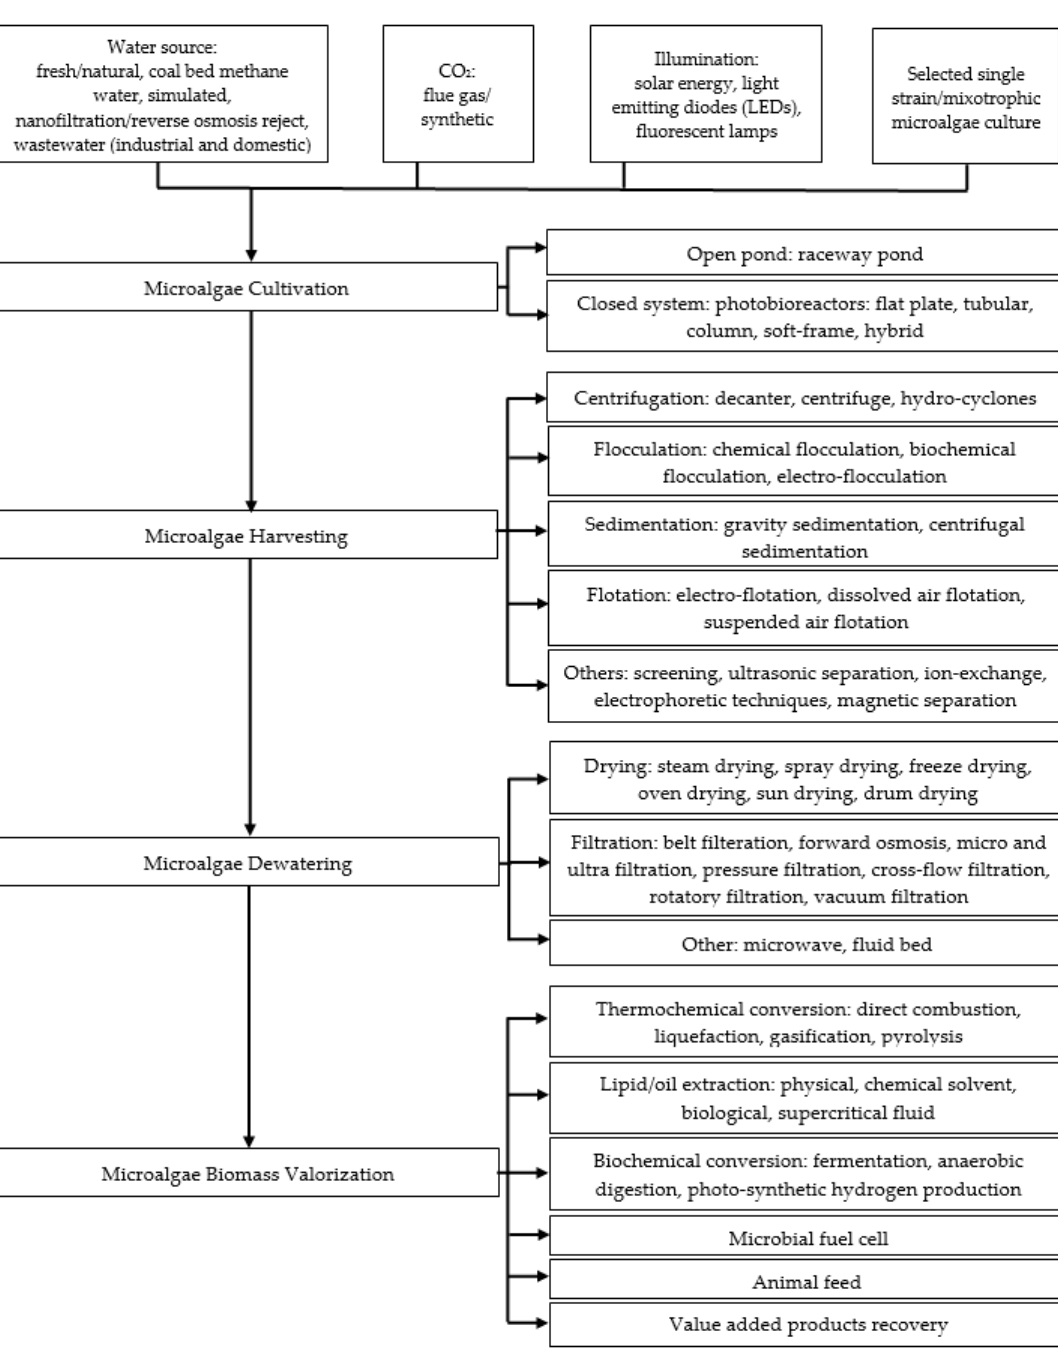
Figure 4. The many available process steps in microalgal biomass cultivation and microalgae-to- biofuel conversion. biofuel